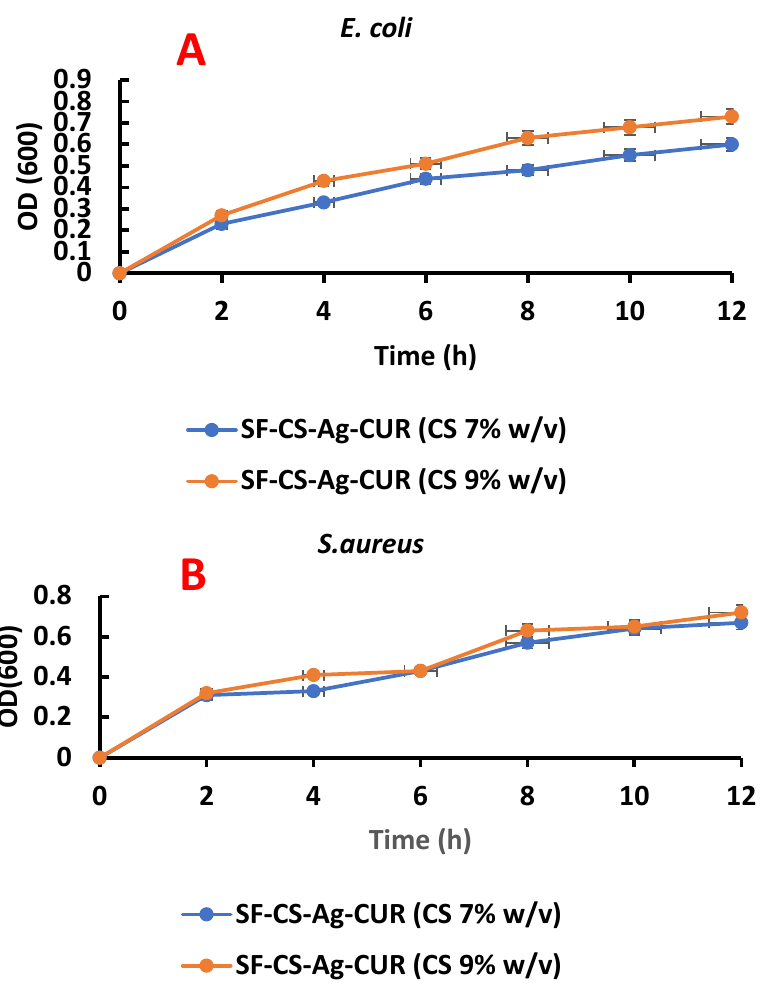
Figure 10. OD measurement of ( A ) E. coli and ( B ) S. aureus for MIC concentration of SF-CS-Ag-CUR (CS 7% w / v ) and SF-CS-Ag-CUR (CS 9% w / v ).